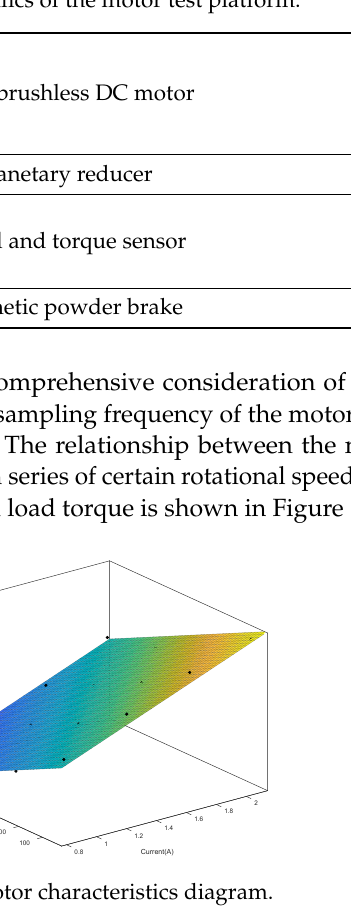
Figure 13. Motor test diagram. Table 5. Specifics of the motor test platform.